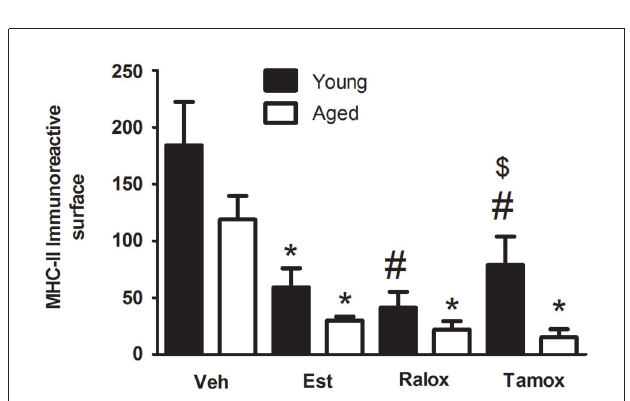
FIGURE 3 | Volume fraction of MHC-II immunoreactive microglia within a distance of 350 µ m from the lateral border of the wound in young and aged animals injected with vehicle (Veh) n = 6 (young) and 5 (aged), estradiol (Est) n = 4 (young and aged), raloxifene (Ralox) n = 6 (young) and 4 (aged), or tamoxifen (Tamox) n = 5 (young) and 4 (aged) . Data are represented as means + / − SEM. * Significant difference ( P < 0.05) vs. vehicle values. * P < 0.05 vs. vehicle (young); # P < 0.05 vs. vehicle (aged); $ P < 0.05 young vs. aged treated with same SERM.